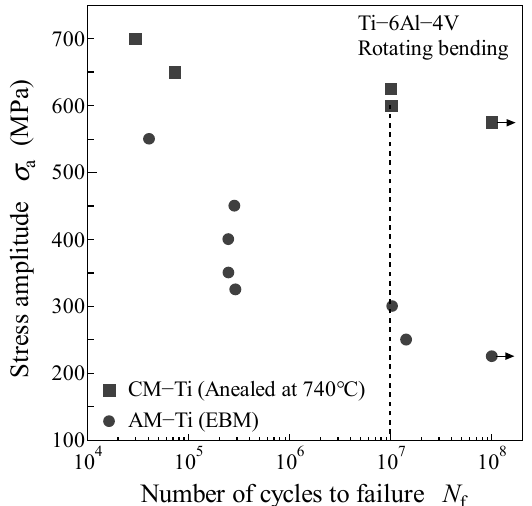
Figure 9. S-N diagram of conventionally manufactured and EBMed Ti-6Al-4V.